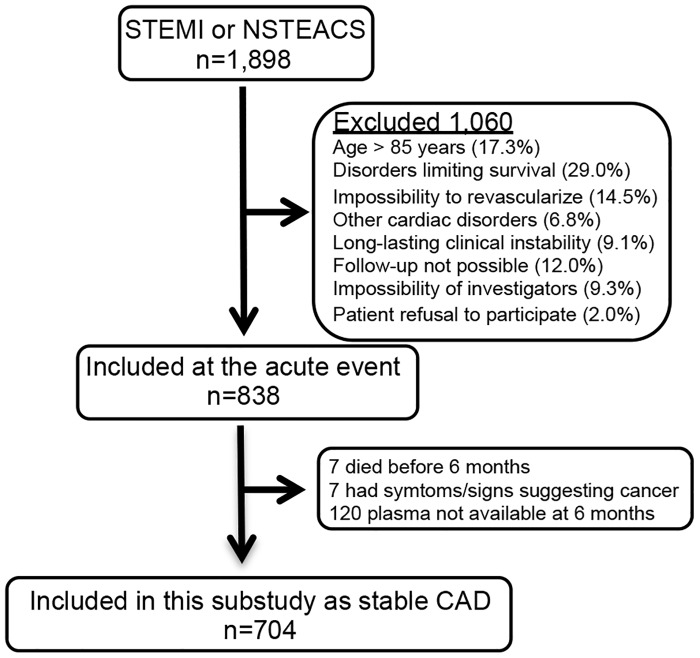
Recruitment flow-chart.
CAD: Coronary artery disease. NSTEACS: Non-ST elevation Acute Coronary Syndrome. STEMI: ST-elevation myocardial infarction.